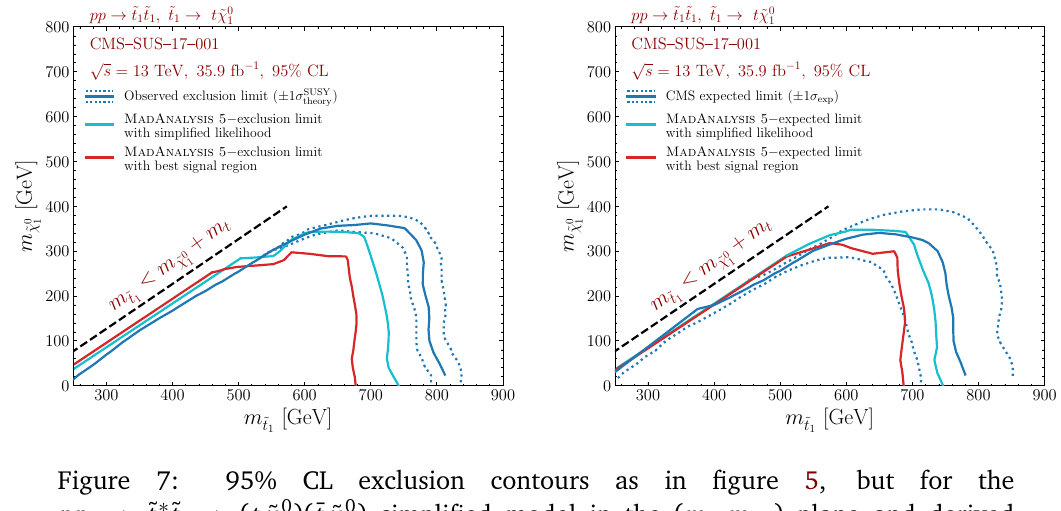
) plane and ˜ t , m ˜ χ 0 1